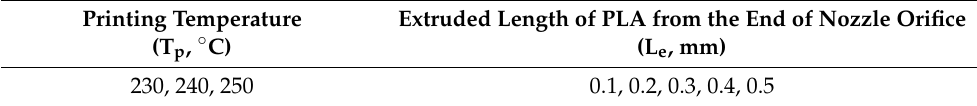
Table 1. Parameters for finite element model during the extrusion process.